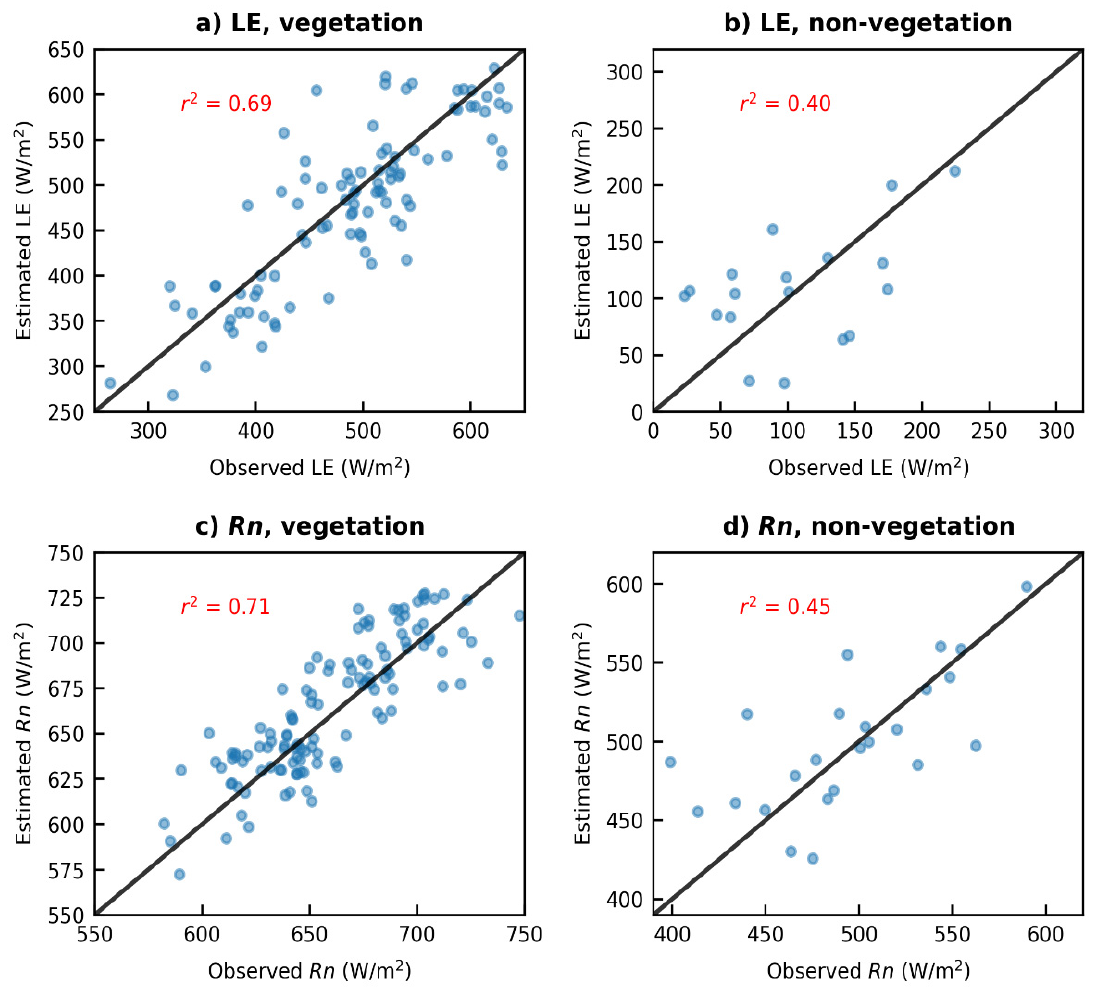
Figure 10. Estimated LE and Rn from WAPT model compared with observations on vegetation (wetland and corn) ( a , c ) and non-vegetation (desert, desert steppe, Gobi) ( b , d ) surfaces during June to September in 2012.